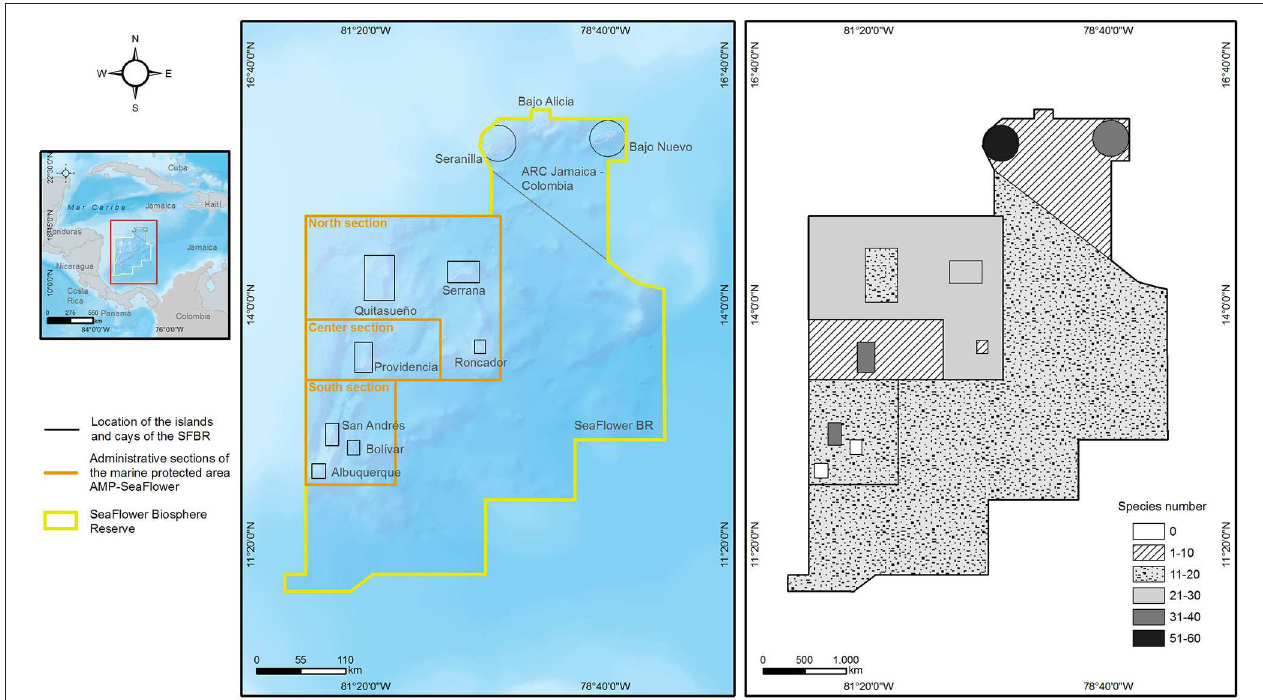
FIGURE 1 | Location of the SeaFlower Biosphere Reserve (SFBR), indicating the locations considered in the Checklist (left) and comparing the number of species registered in each one (right).